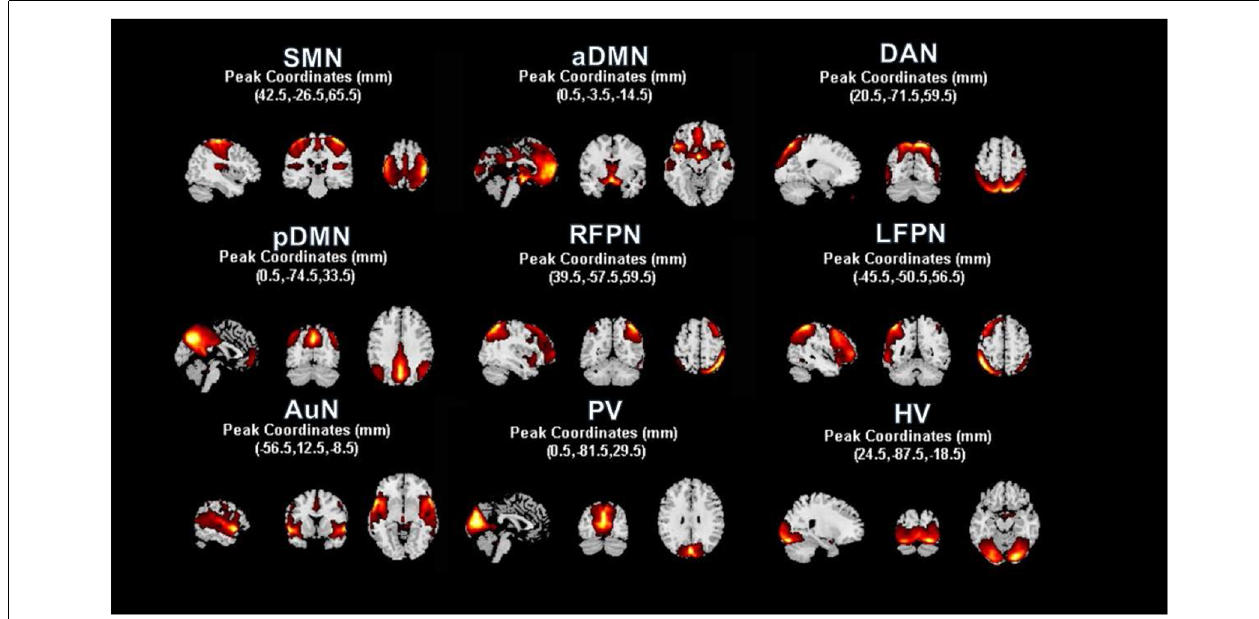
FIGURE 2 | Resting state functional networks identified by ICA. We identified nine meaningful RSNs and extracted the corresponding mean time courses. In each RSN, peak coordinates in Montreal Neurological Institute (MNI) space helped us to verify the location of these nine built networks. A one-sample t -test was used to find the significant voxels within their networks ( p < 0.01, voxel correlation via FDR).